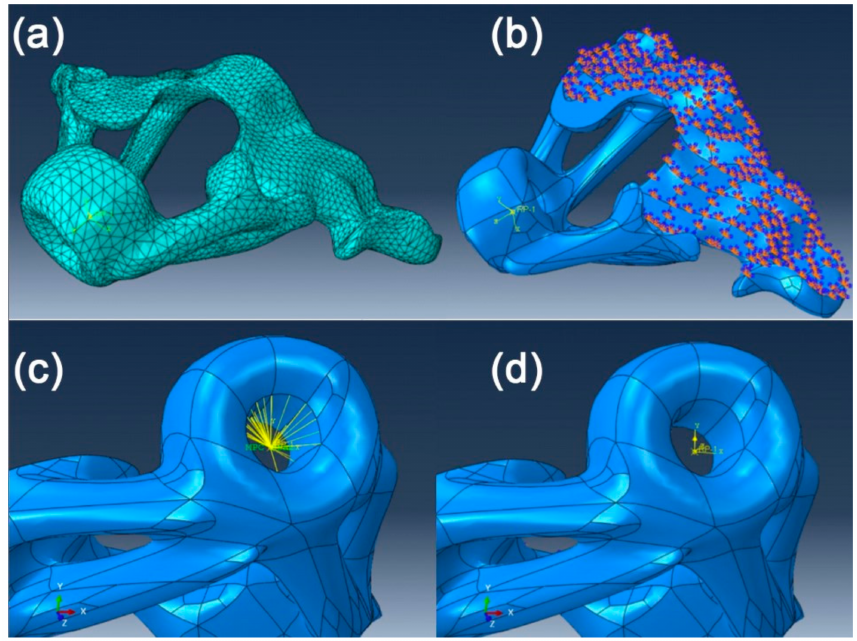
Figure 4. ( a ) meshed surgical guide model; ( b ) applied boundary constraints; ( c ) MPC constraint boundary condition; ( d ) applied load on the surgical guide MPC